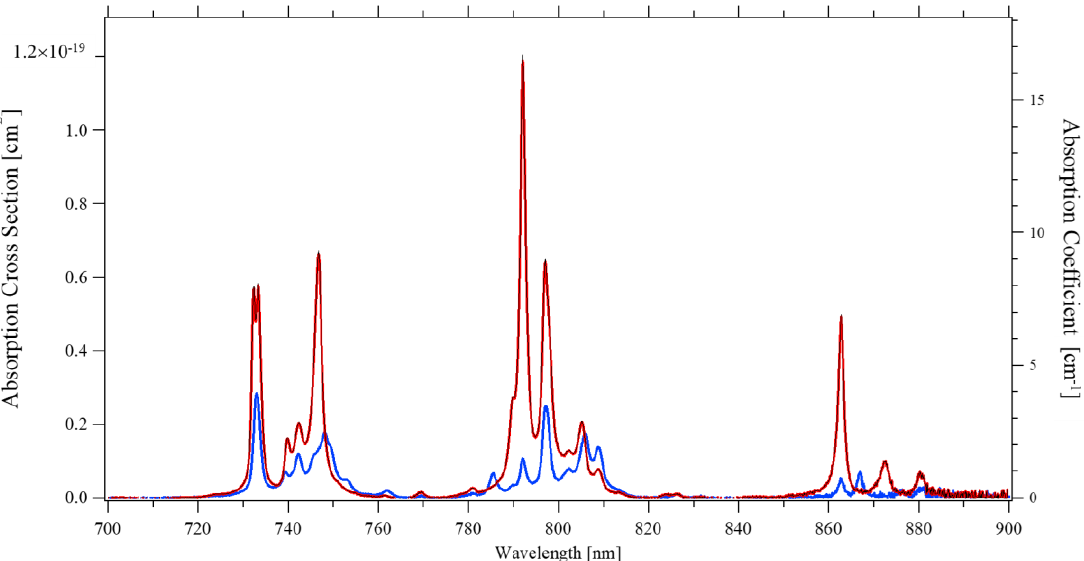
Figure 2. Absorption spectrum of 1 at% Nd:YLF at room temperature for π–polarized light (Red) and σ–polarized light (Blue).